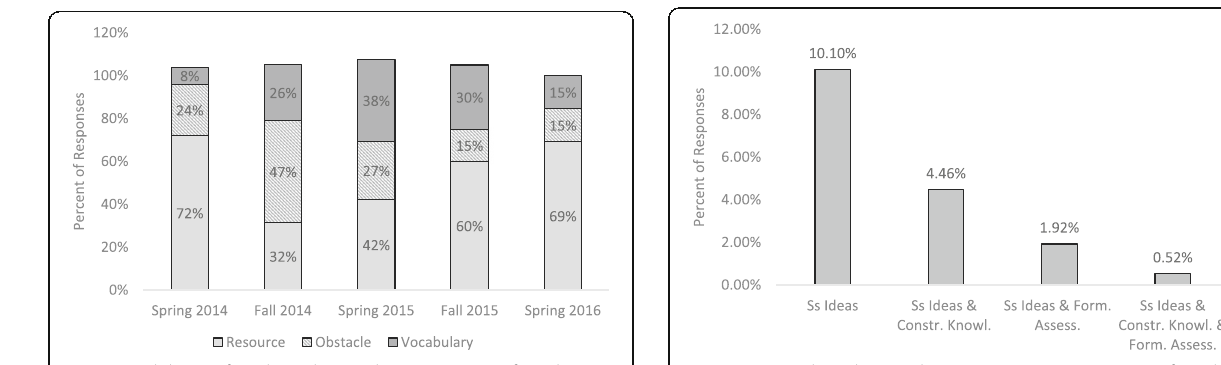
Fig. 6 Breakdown of student ideas codes. Percentage of week 15 teaching and learning responses coded as student ideas that talked about student ideas as a resource (light gray), obstacle (patterned), or simply used vocabulary (dark gray)